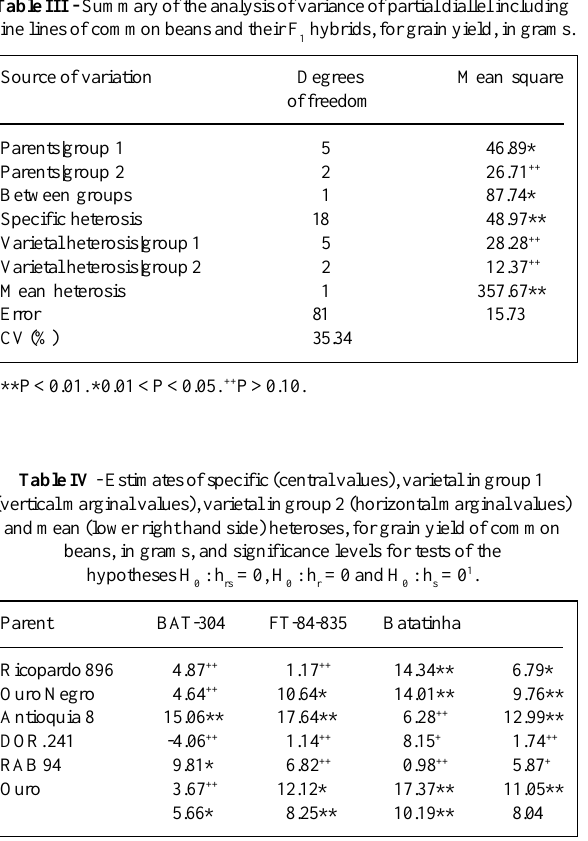
Table III - Summary of the analysis of variance of partial diallel including nine lines of common beans and their F